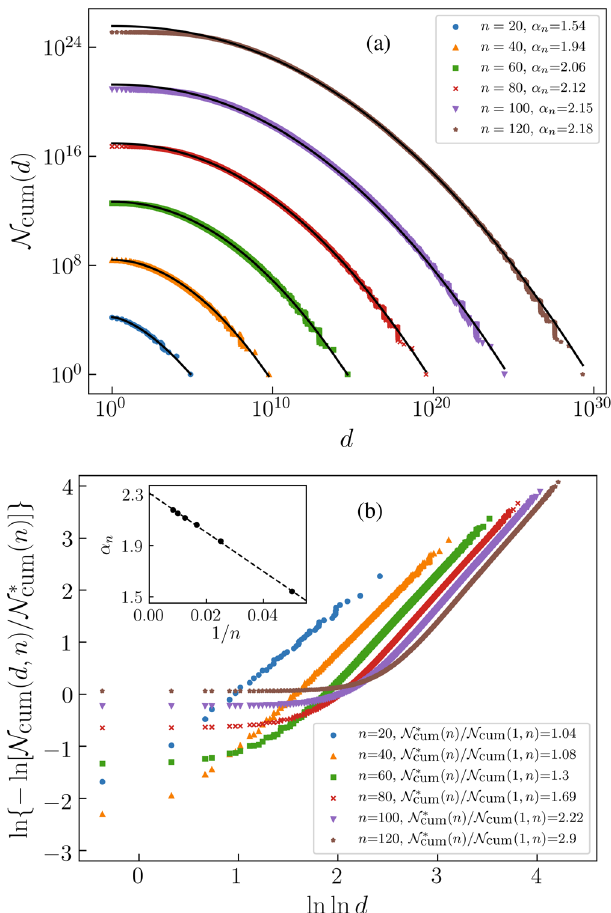
FIG. 4. (a) Cumulative degeneracy distribution for n ¼ 20 , 40, 60, 80, 100, 120. The black curves represent least-squares fittings d; n Þ as ln N (cid:3) n Þ þ B of ln N ln α n d for each n . (b) Cumu- n cum ð cum ð d; n Þ = N (cid:3) n Þ(cid:2)g lative degeneracy distribution ln f − ln ½ N cum ð cum ð versus ln ln d for n ¼ 20 , 40, 60, 80, 100, 120. Inset: Exponent α versus 1 =n